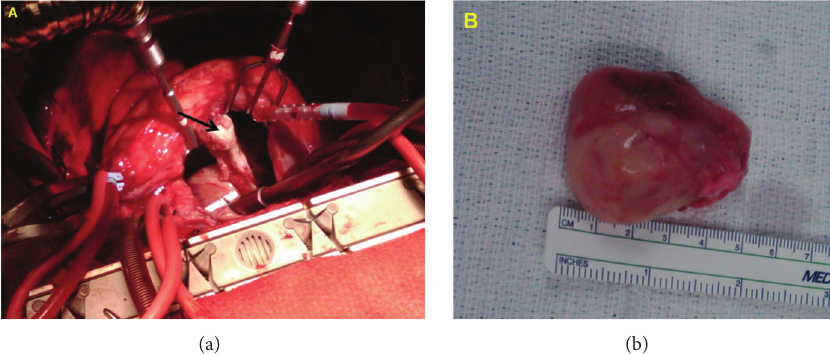
Figure 2: Presentation 2. (a) Tumor in the posterior aspect of the left atrium (arrow). (b) Excised left atrial